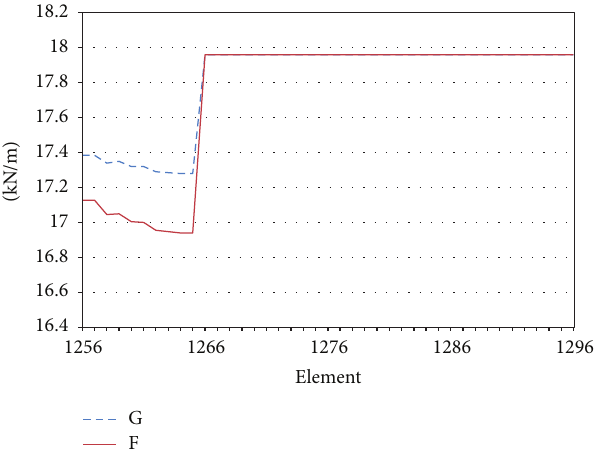
Figure 11: Stiffness of unit identification for pier